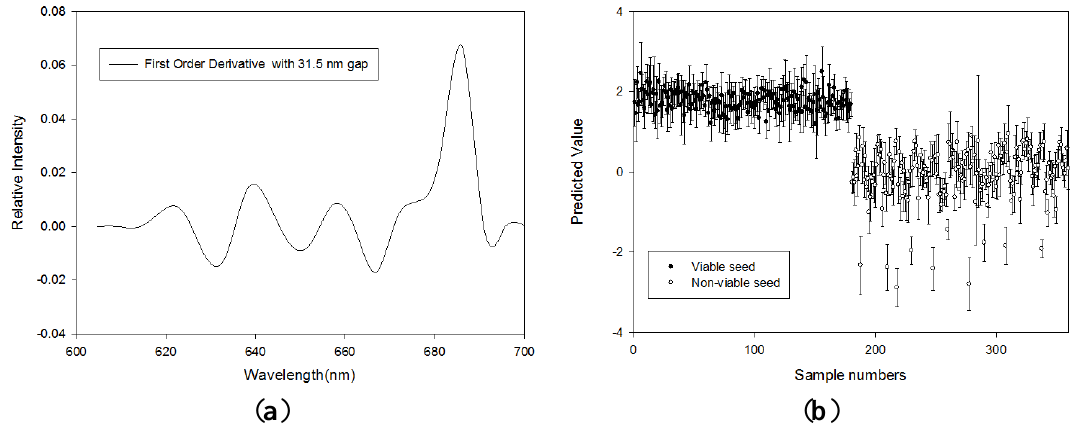
Figure 6. ( a ) Regression coefficients of the PLS-DA model, and ( b ) the PLS-DA prediction results obtained using the first-order derivative with a 31.5 nm interval to discriminate between viable and nonviable pepper seeds based on the reflectance spectra under RL (600–700